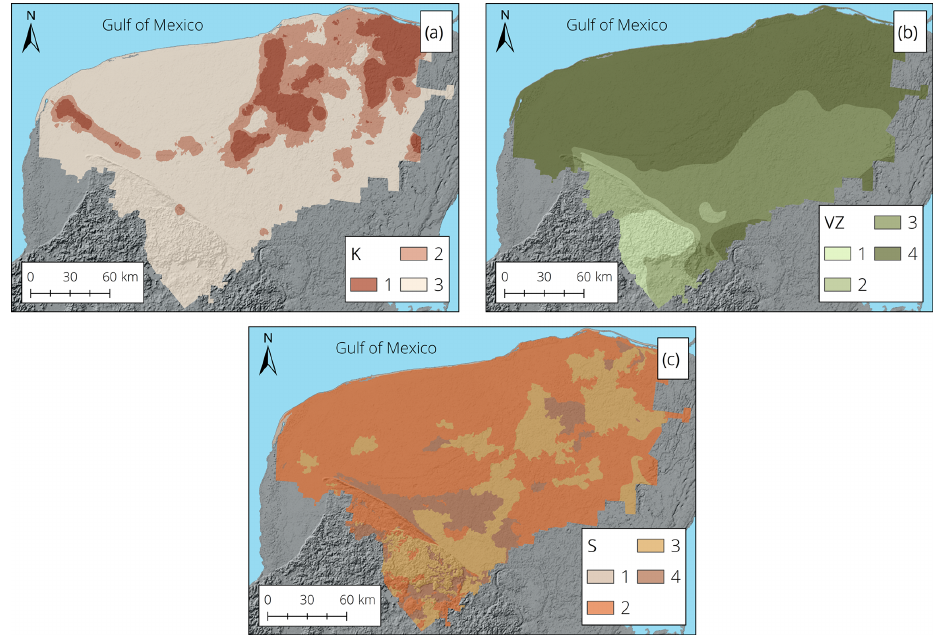
Figure 6. Selected map layers and attributes’ rates according to the proposed criteria for IKAV-P. (a) Doline density as representative of karstification ( K ). (b) Depth to groundwater as representative of the vadose zone (VZ). (c) Soil clay content as representative of the overlying protection ( S ). Table 1. Selected map layers after the criteria-filtering process proposed by IKAV. Map